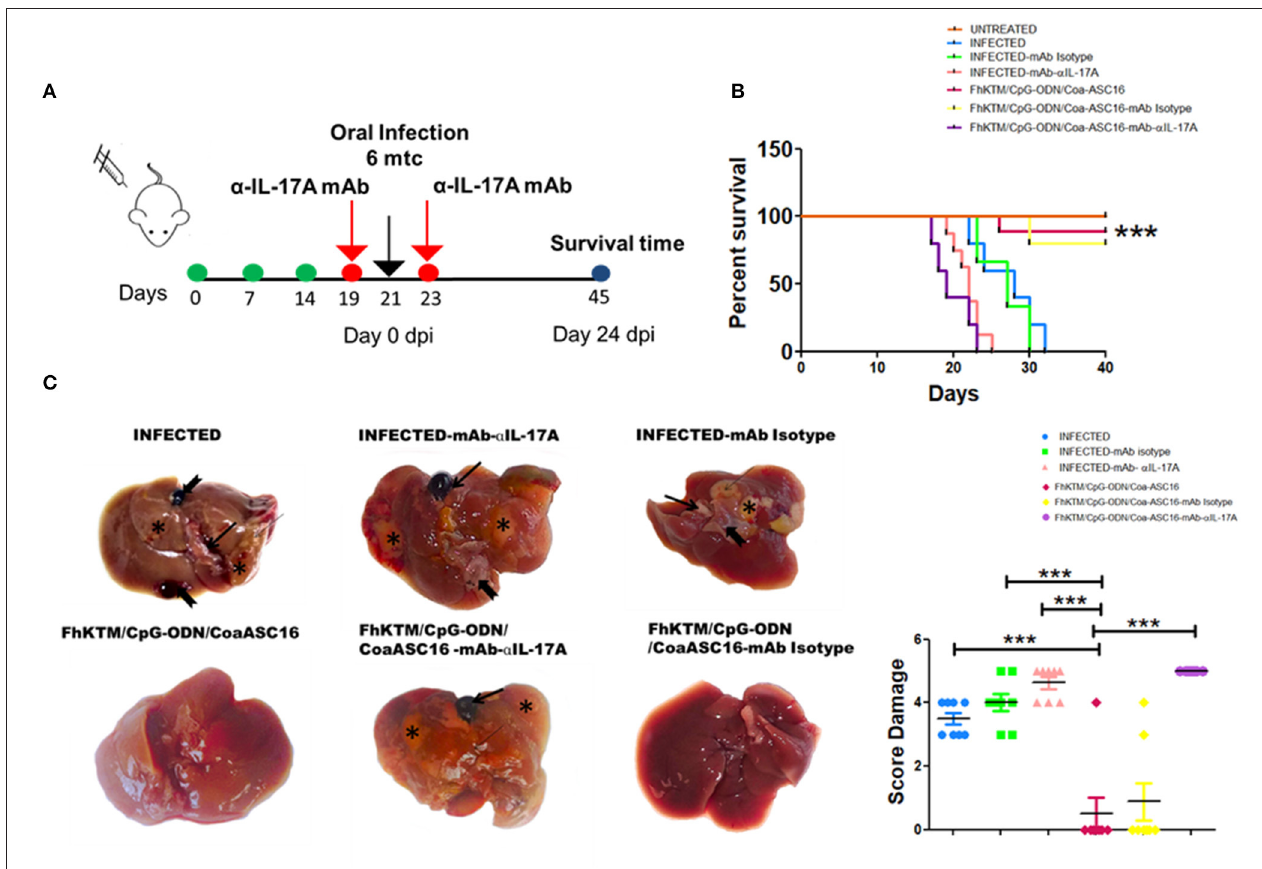
FIGURE 7 | IL-17A neutralization decreased the efficacy of FhKTM/CpG-ODN/Coa-ASC16 vaccination. (A) Mice were administered with anti-IL-17A antibody and the corresponding isotype control (250 µ g i.p) 2 days before and after infections. (B) Kaplan–Meier graphs show survival curves for those mice immunized three times with FhKTM/CpG-ODN/Coa-ASC16 or PBS. IL-17A-mAb and corresponding isotype control (mAb Isotype) were administered 2 days both before and after infection. dpi: days post infection. (C) Left: infected liver showing marked enlargement with distended gallbladder (thick arrow), areas of fibrosis extending (asterix), and larvae on the parenchyma surface (notched arrow). FhKTM/CpG-ODN/Coa-ASC16: liver showing normal size with no observed lesion except in 1 out of 8 mice. Infected-mAb-IL-17A: the liver showing marked severe macroscopic damage (thin arrow) and presented irregular surface denoting hepatic fibrosis (asterix). The presence of larvae on the surface can be seen (notched arrow). FhKTM/CpG-ODN/Coa-ASC16 -mAb-IL-17A: The hepatic parenchyma is severely reduced, firm, and presents an irregular surface (thin arrow) denoting hepatic fibrosis (asterix). Abnormal gross appearance of the distended gallbladder with presence of blood inside (thick arrow). infected-mAb Isotype: the liver is smaller than normal and presents irregular surface tissue denoting hypertrophied (thin arrow) and replaced with fibrosis (asterix) and a fluke released after the rupture of the gallbladder (notched arrow). FhKTM/CpG-ODN/Coa-ASC16-mAb Isotype: liver showing no apparent gross pathology except for in 2 out of 8 mice. Right, the score damage was assessed by the extensión of liver damaged (score range 0 to 5). The data shown are pooled from two independent experiments with total ( n = 5–8 per group). The statistical differences among survival curves were calculated by using Mantel–Cox test. *** p <